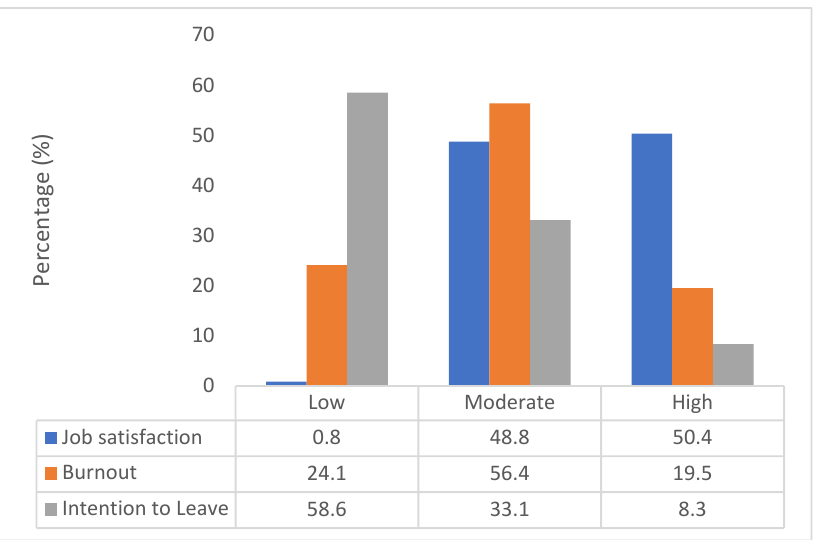
Figure 1. Level of job Satisfaction, burnout, and intention to leave among researchers.